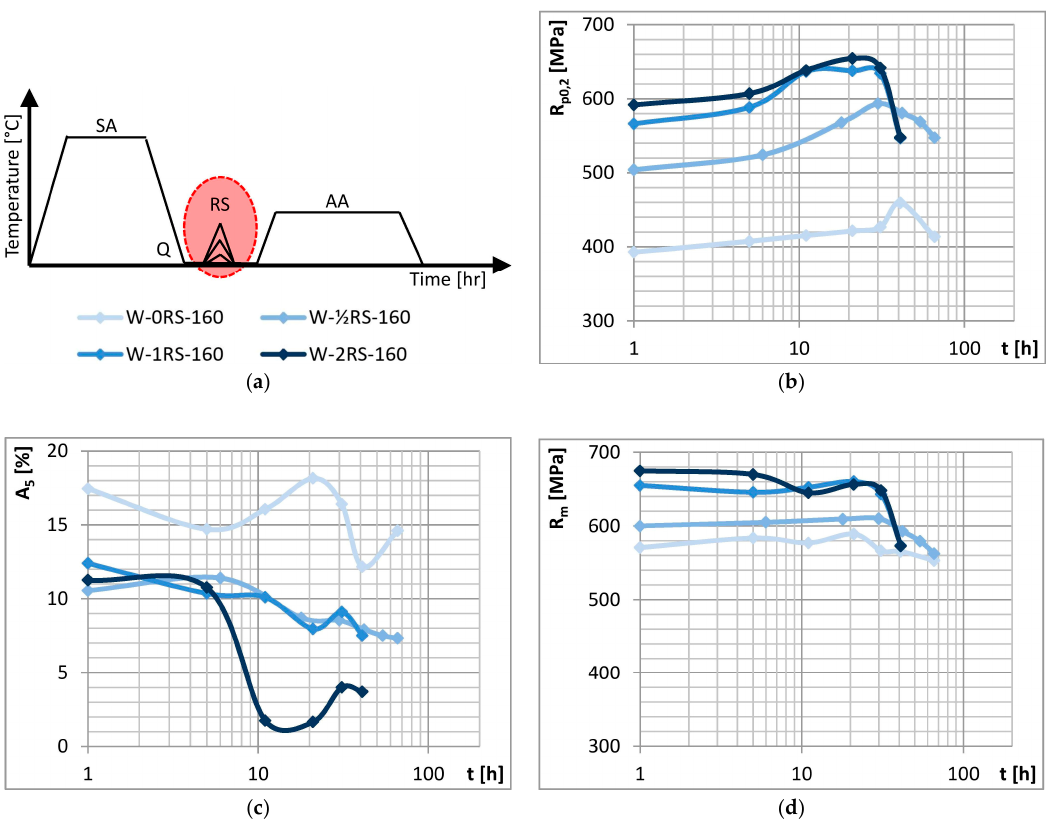
Figure 3. ( a ) Schematic representation of the strain magnitude experiment and its results: ( b ) yield strength ( c ) elongation and ( d ) ultimate strength vs. time of AA. strength ( c ) elongation and ( d ) ultimate strength vs. time of